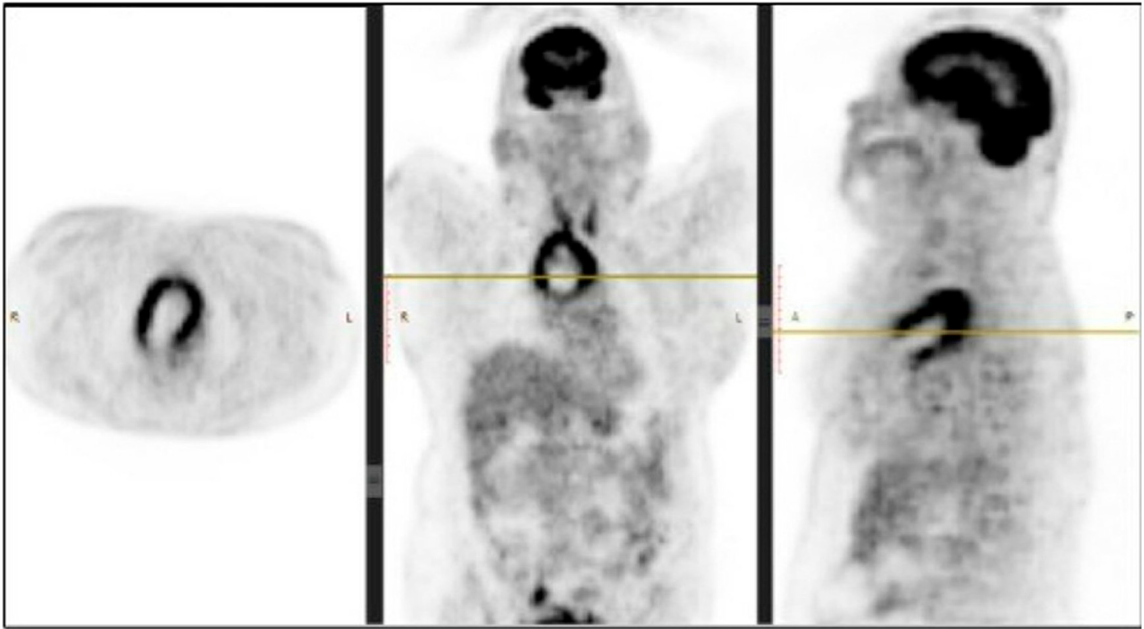
Figure 3. PET scan showing metabolic activity in the mediastinal mass. Abbreviations: R: Right; L: Left